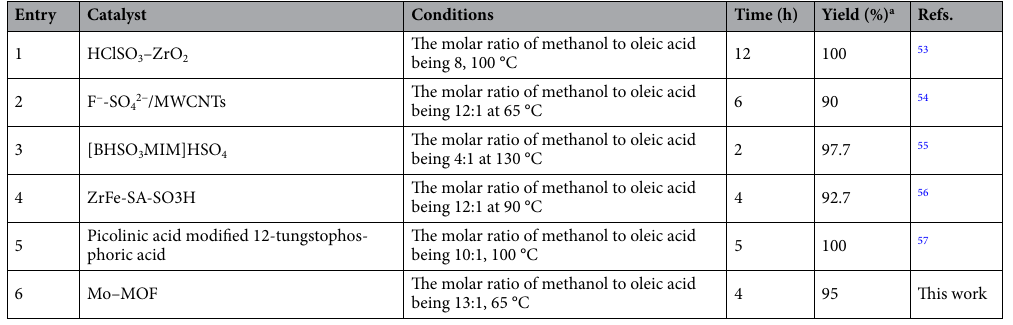
Table 4. Comparison of results for Mo–MOF in esterification of reaction of oleic acid. a Isolated